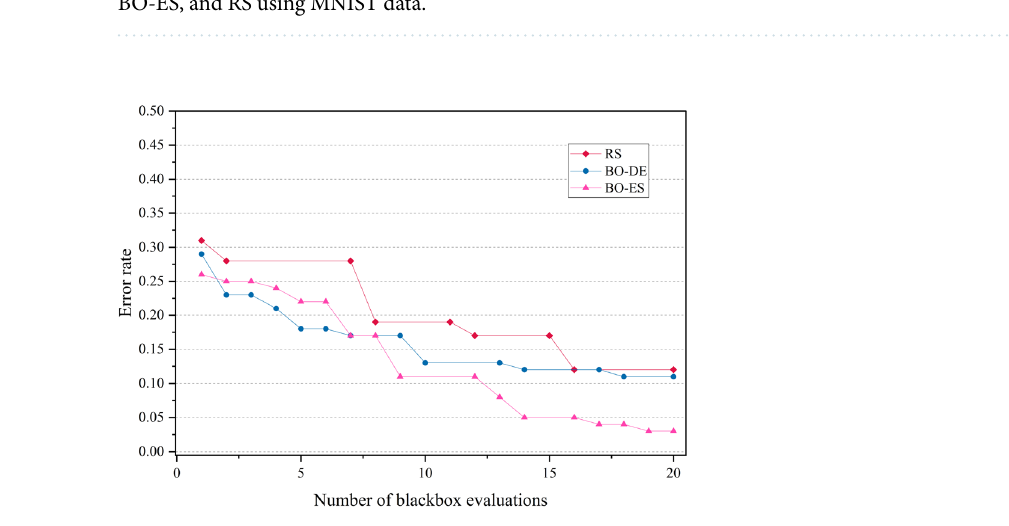
Figure 10. Comparison of the error rates of AlexNet against the number of function evaluations for BO-ES, BO-ES, and RS using SVHN data.